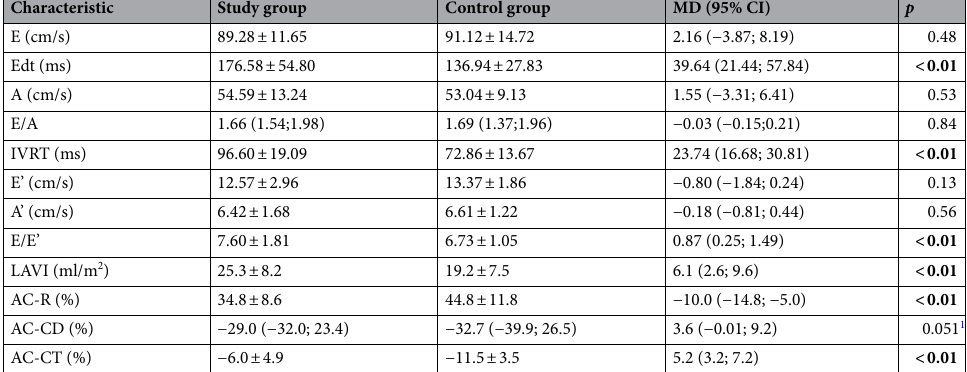
Table 3. Comparison of the diastolic parameters in the study and control groups. Significant values are in bold. E early diastolic mitral inflow velocity, A atrial diastolic mitral inflow velocity, Edt E wave deceleration time, MD mean/median differences, CI confidential interval, IVRT isovolumetric relaxation time, E ’ early diastolic velocity, A ’ late diastolic velocity. MD mean/median differences, CI confidential interval, LAVI left atrial volume index, AC-CT contractile strain, AC-R reservoir strain, AC-CD conduit strain.